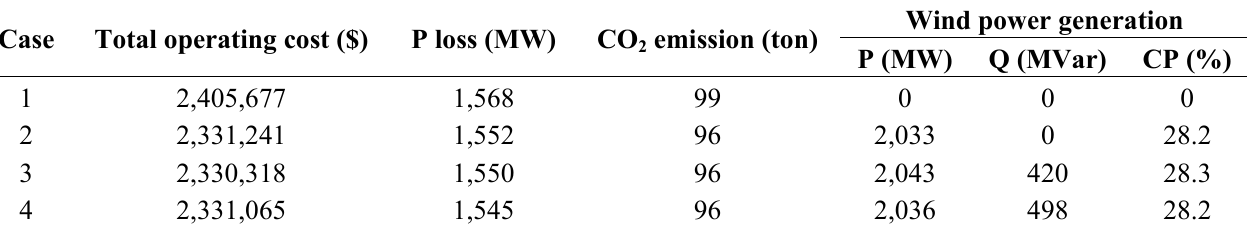
Table 3. Optimal solutions of the proposed